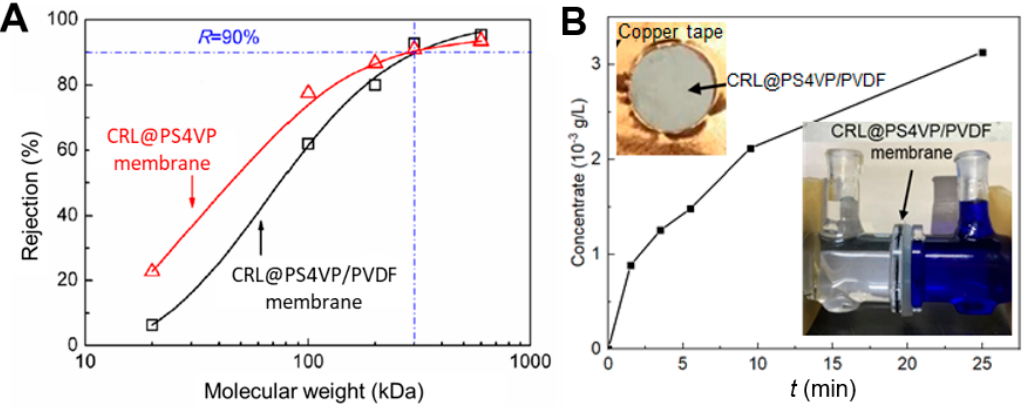
Figure 4. Penetration performance. ( A ) MWCO curves of the CRL@PS4VP / PVDF membrane and CRL@PS4VP membrane. ( B ) Diffusion curve of Victoria blue dye (Mw = 506.09 Da) through the CRL@PS4VP / PVDF